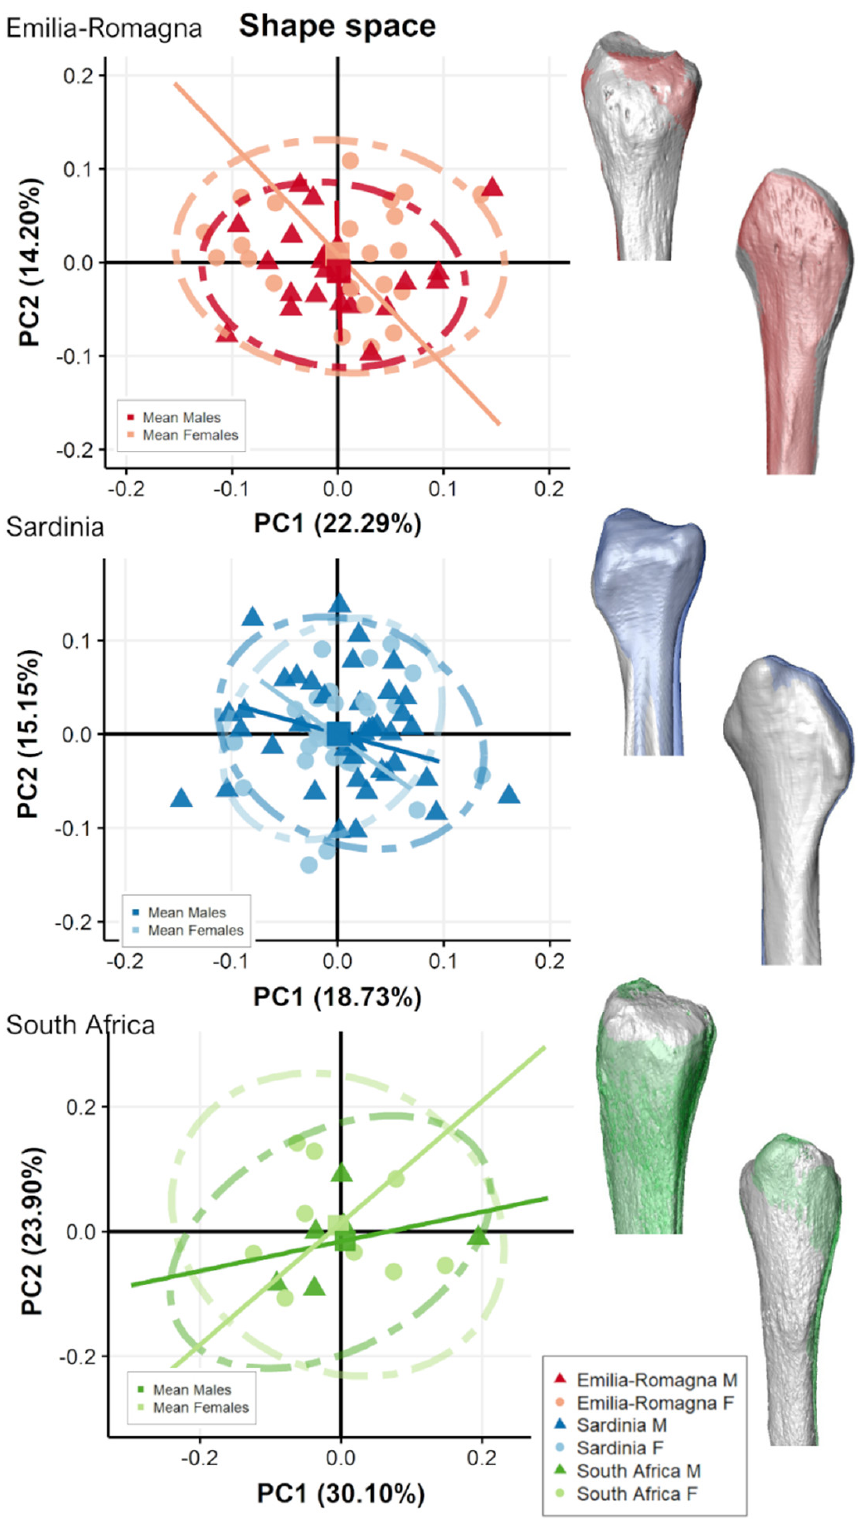
Figure 5. Scatterplot of shape-space PC scores of proximal fibular epiphyses for the two Italian (Emilia-Romagna and Sardinia) and the South African populations, divided by sex and presenting mean male (colored) and female (grey) shape variation along the PC axes, represented in the scatterplot as squared dots, in medial ( top ) and lateral ( bottom ) views. Lines represent allometric trajectories for males and females for each population.